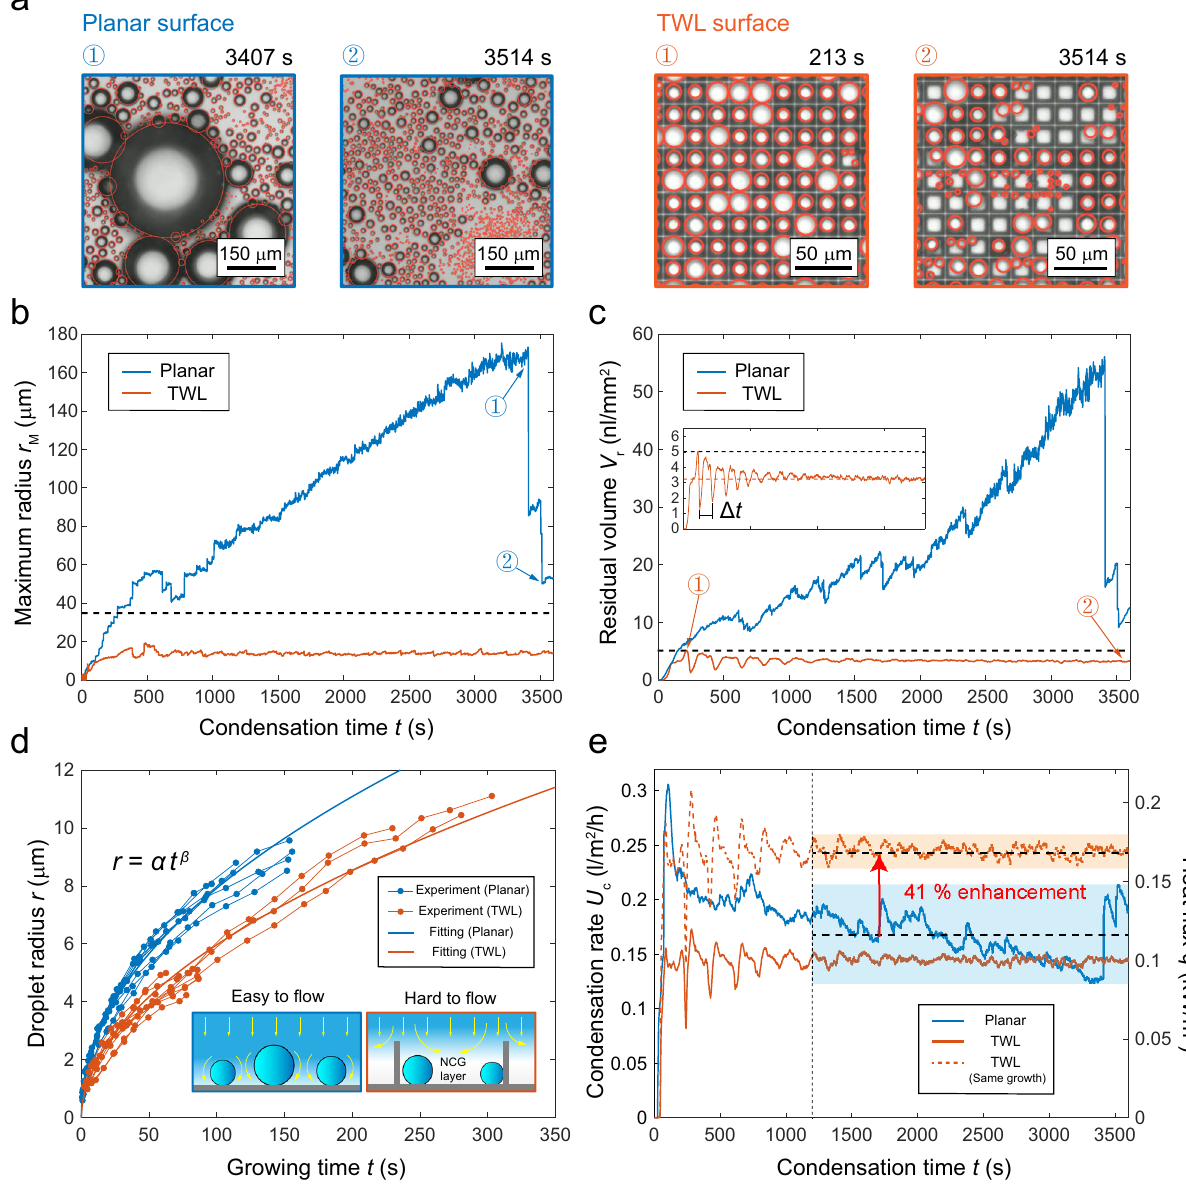
Fig. 4 | Variation of condensation properties with time. a Breath fi gures at cer- tain moments during condensation. The left-hand side shows two images on the planar surface. The condensation time for moment ① is 3407s while that for moment ② is3514s.Theright-handsideshowstwo fi guresontheTWLsurface.The condensation time for moment ① is 213s while that for moment ② is 3514s. b Variation of maximum radius with time on the two surfaces. Points ① and ② correspond to the breath fi gures on the planar surface in Fig. 4a. c Variation of residualvolumewithtimeontwosurfaces.Points ① and ② correspondtothebreath fi gures on the TWL surface in Fig. 4a. Inset shows the enlarged curve of residual volumeontheTWLsurface.Theblackdashedlinesin b and c representthestate-of- Consequently, the variation tendency of V r is similar to that of r M . On the TWL surface, V r reaches a stable value of 3.2 nl/mm 2 , which is also smaller than the state-of-the-art result (5nl/mm 2 ) 7 . The enlarged curve on the TWL surface in the inset shows a trend similar to damped oscillation with a period of Δ t =192s, which approximates the time span required for the refreshing of a single lattice. The peak for this curve is reached at moment ① on the TWL surface. As shown in the corresponding breath fi gureon the right of Fig. 4a,most cells are fi lled